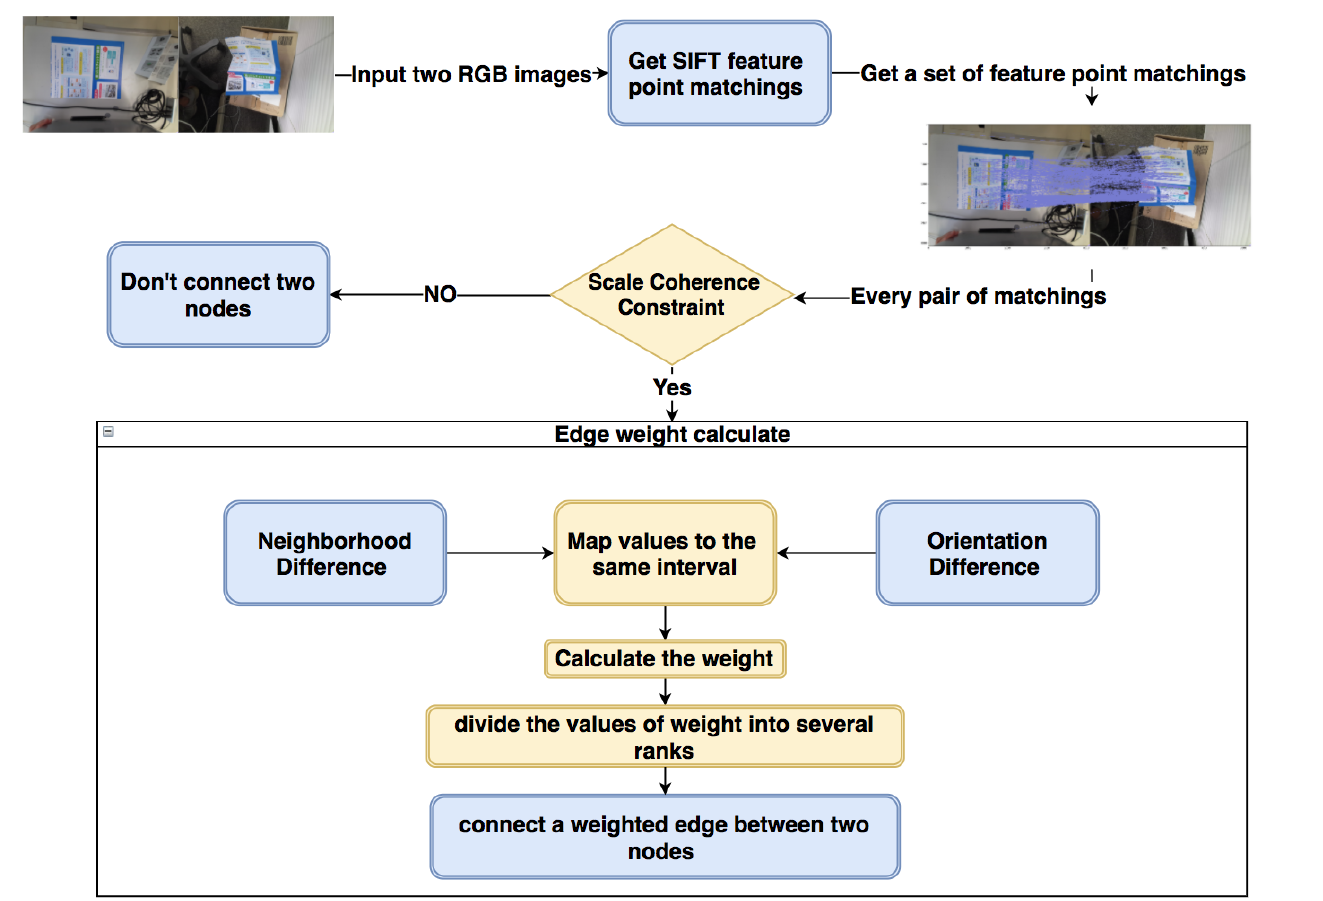
Figure 2. Weighted graph building process.